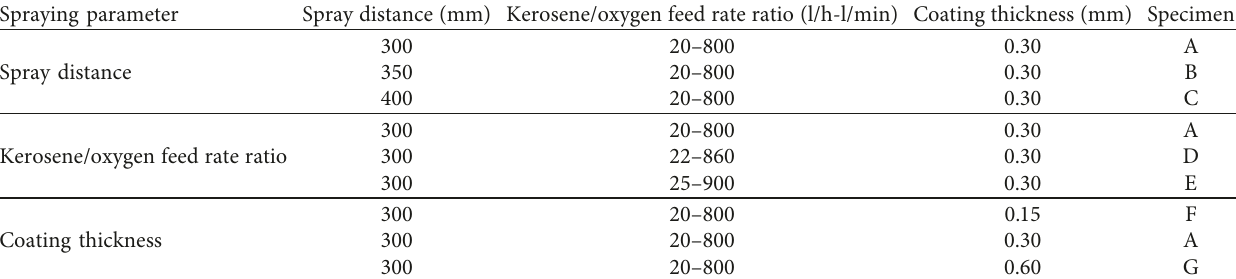
Table 1: Spraying parameters employed in the HVOF spraying process. Spraying